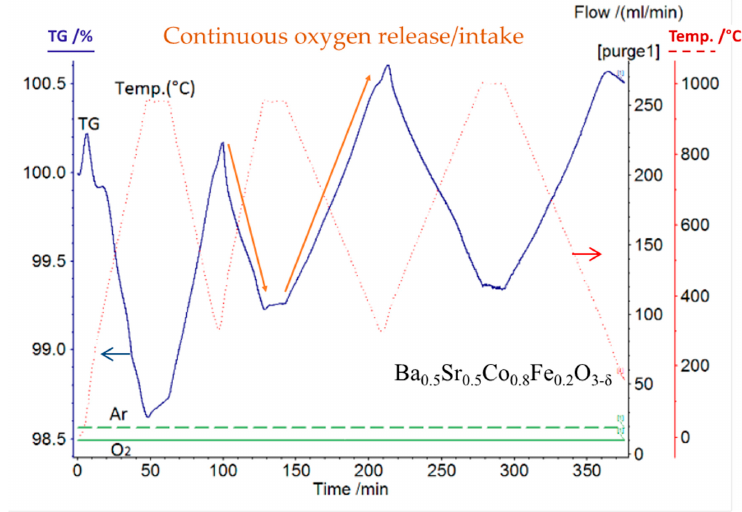
Figure 8. Thermogravimetry (TG) analysis of Ba 0.5 Sr 0.5 Co 0.8 Fe 0.2 O 3 − δ perovskite during redox cycles showing a continuous release and intake of oxygen under a dynamic heating program in 20% O 2 /Ar.